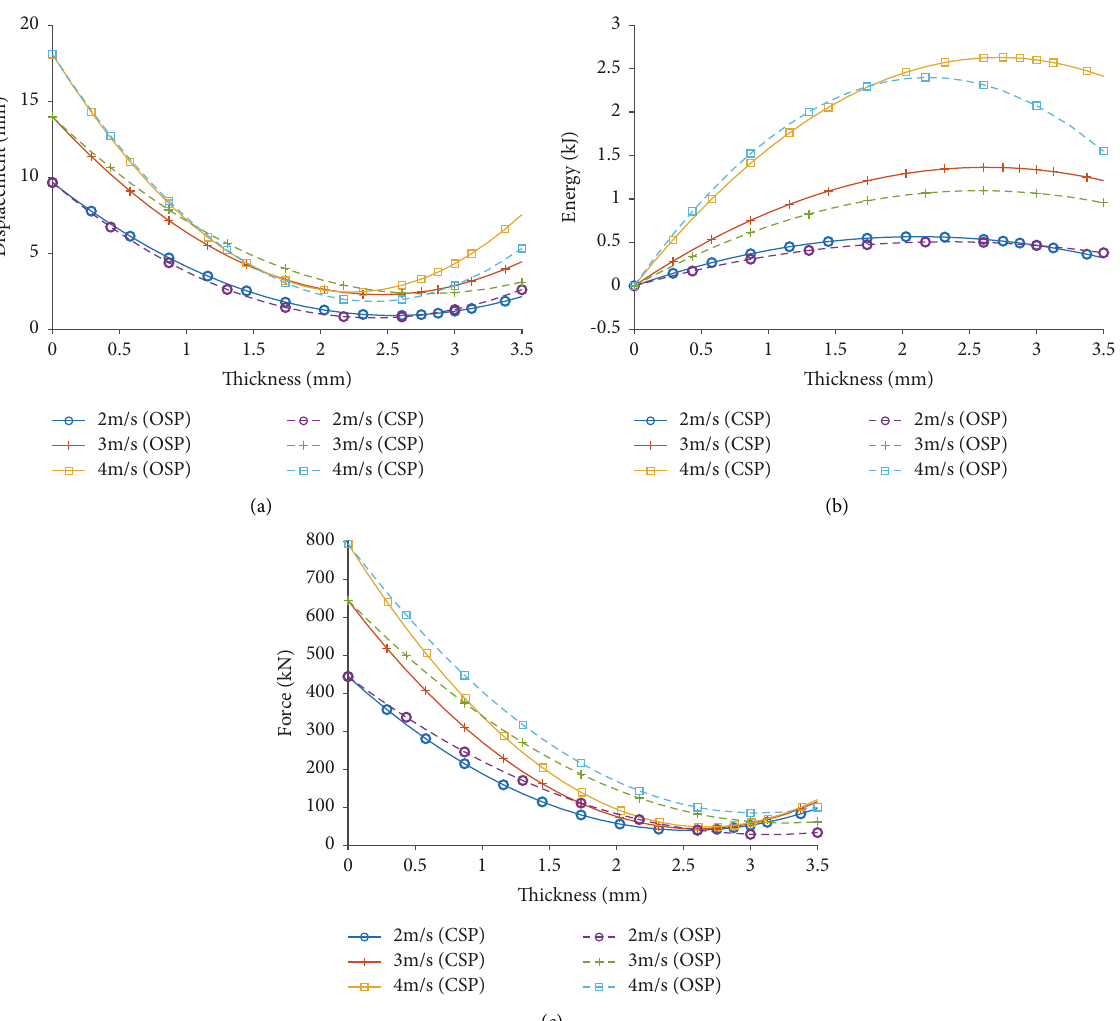
Figure 9: Influence curves of specimen thickness. (a) Lateral displacement peak value of the top of the column. (b) Total energy peak value of the CSP/OSP specimen. (c) Lateral impact force peak